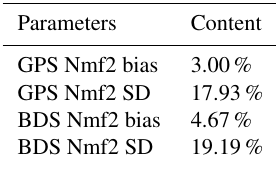
files was found to be as small as about 0.05 % to 0.2 % (and Table 3. The statistics of the GNOS GPS and BDS RO NmF2